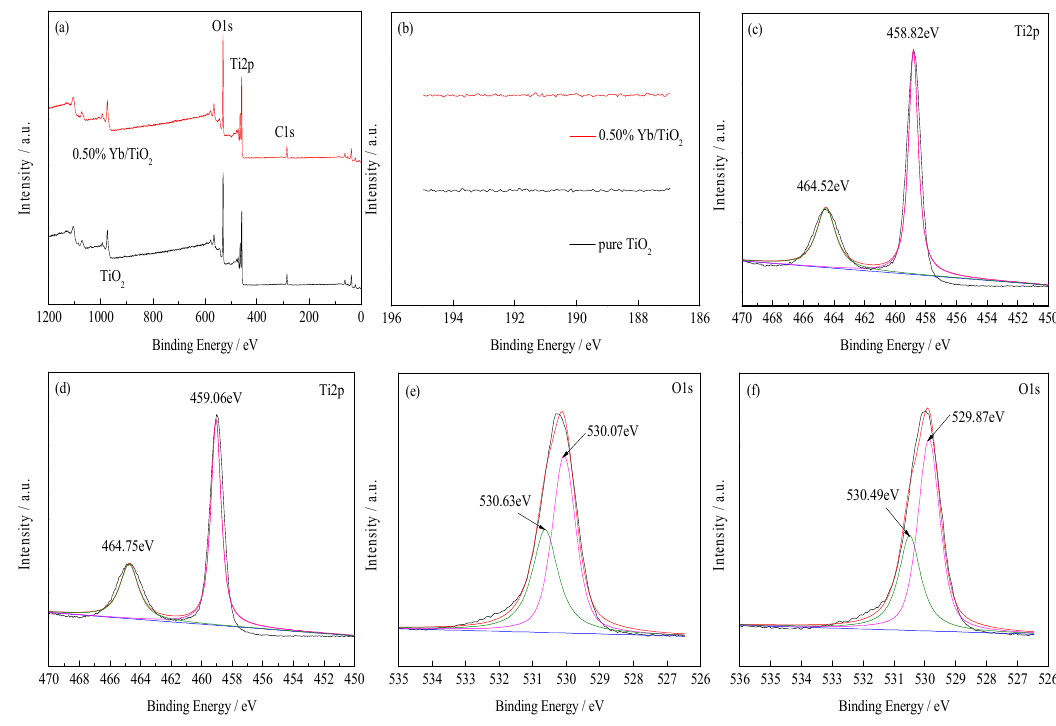
Figure 2. X-ray photoelectron spectroscopy (XPS) spectra. Survey spectra ( a ), Yb3d ( b ), Ti2p and O1s of pure TiO 2 ( c ) and ( e ), and Ti2p and O1s of Yb/TiO 2 ( d ) and ( f ), respectively. Different color mean different curves in Figure 2c,d,e,f. Black, original curve; red, fitted curve; green, hydroxyl oxygen curve; pink, crystal lattice oxygen curve; blue, background.